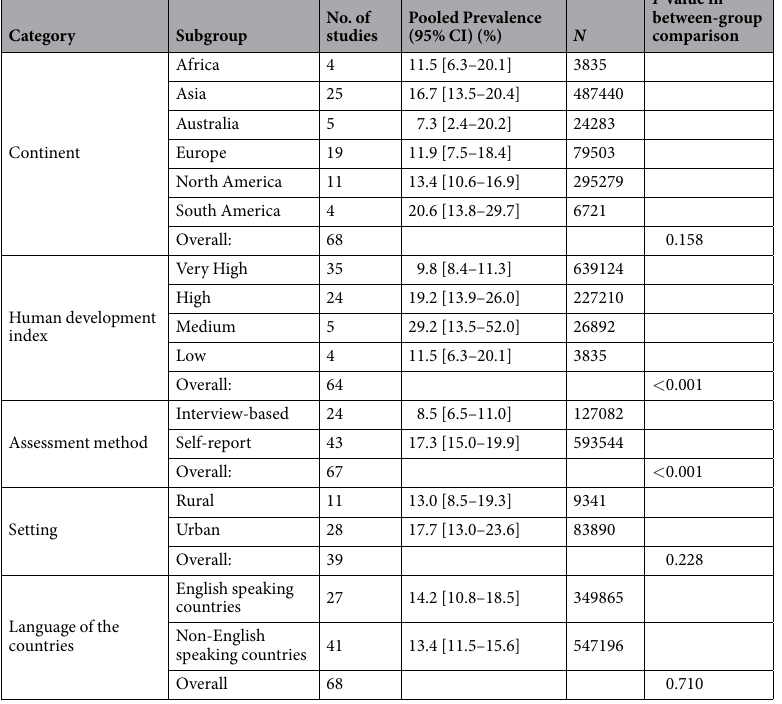
Table 4. Point prevalence of depression according to different